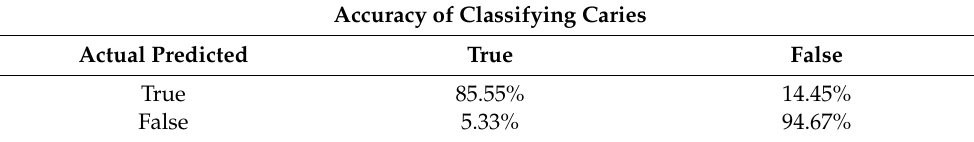
Table 9. Truth table of accuracy for classifying restorations.